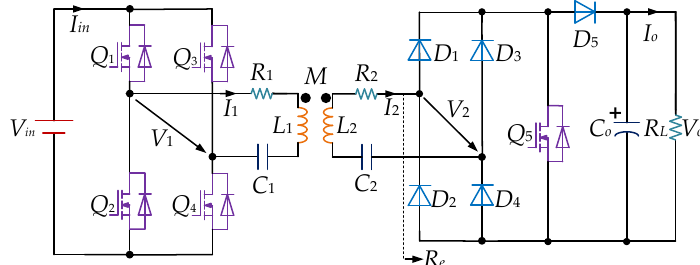
Figure 1. Schematic diagram of proposed simultaneous wireless information and power transfer (SWIPT) structure with controlled chopper receiver.